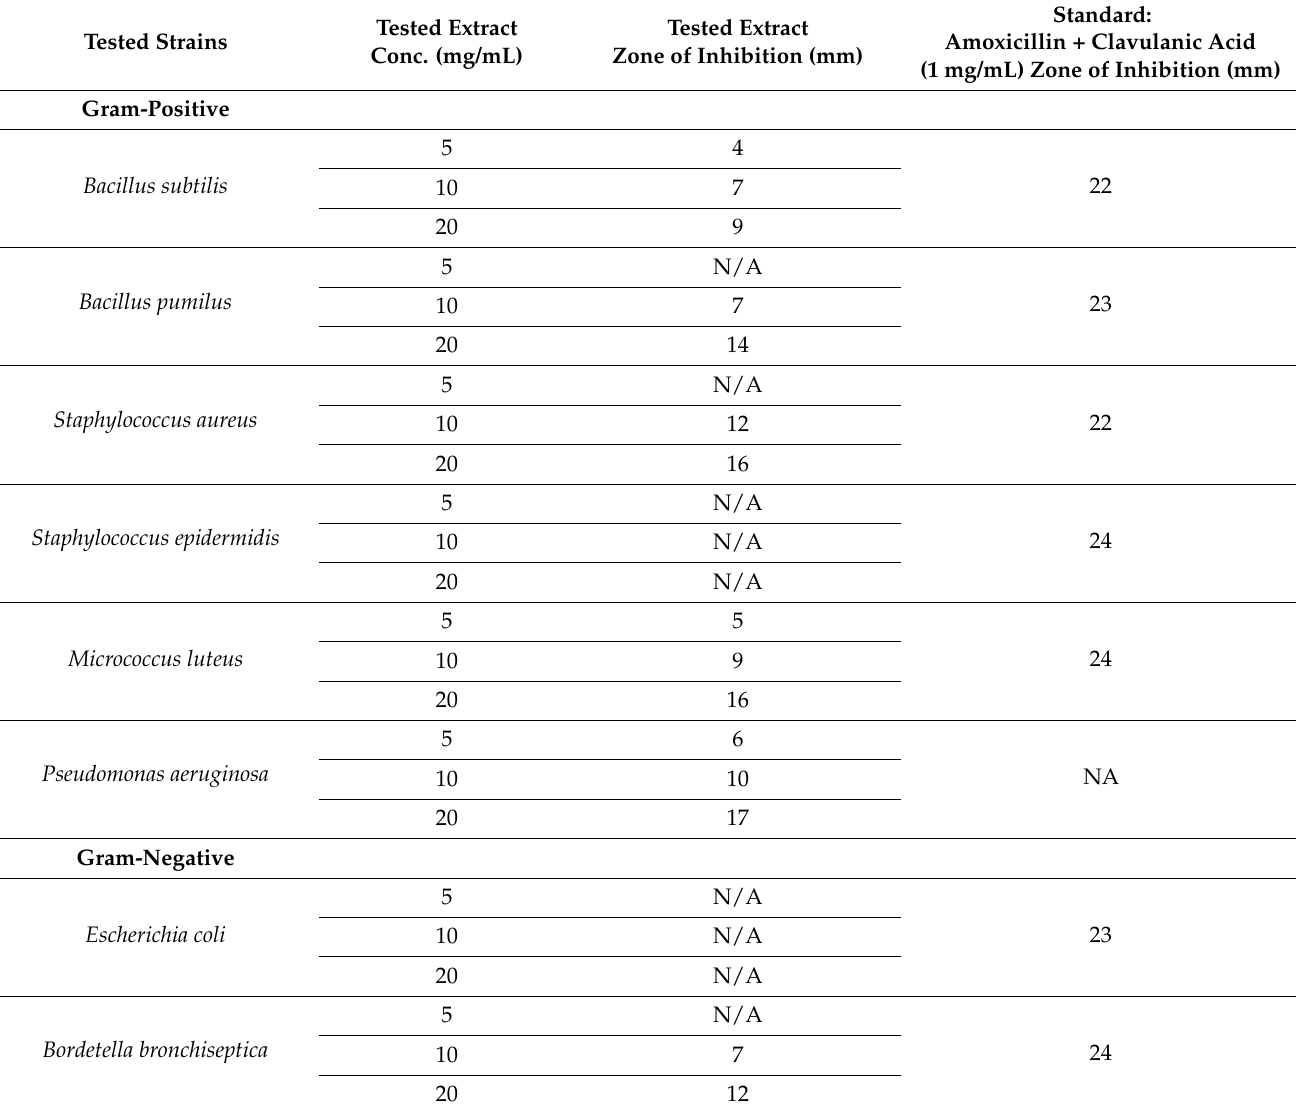
Table 3. Zone of inhibition against different bacterial strains of ethanolic extract of Z. pentandra .